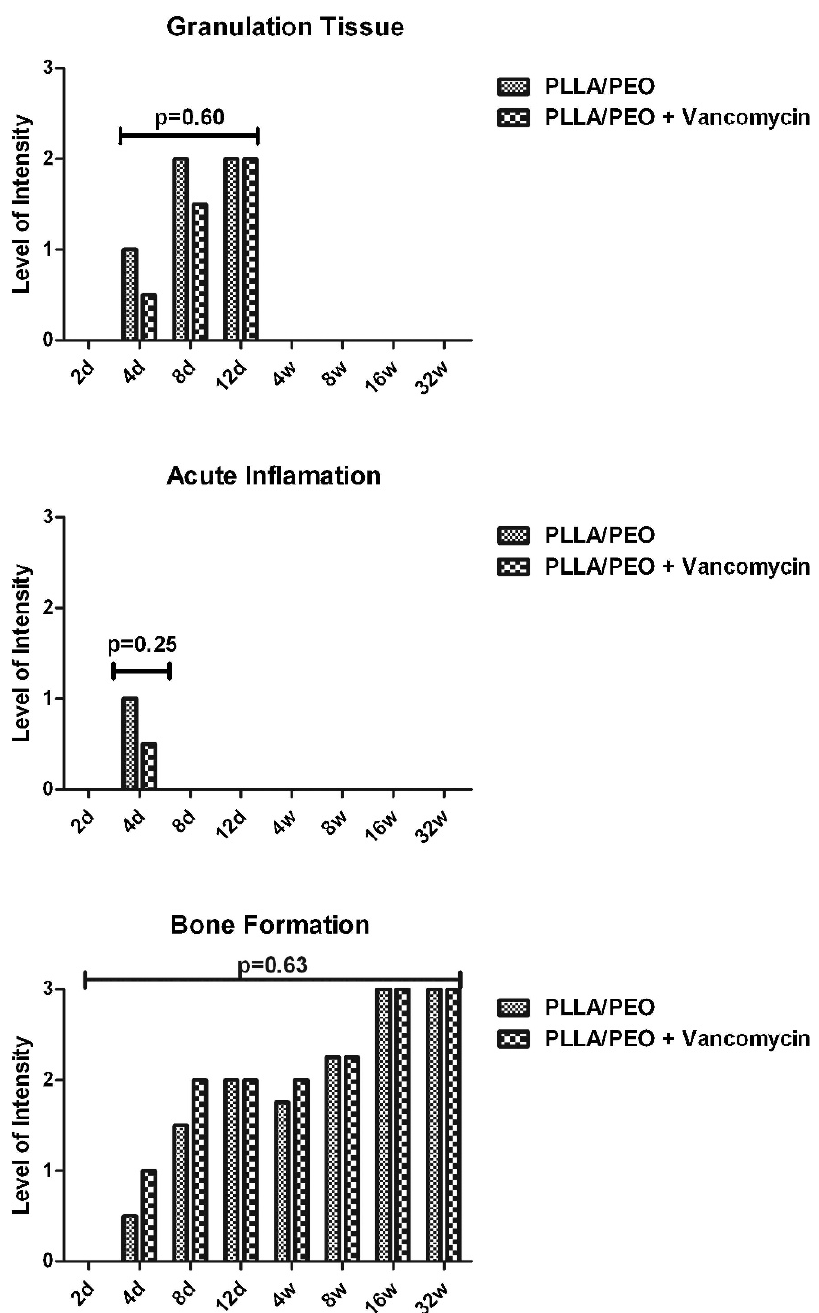
Figure 4 - Histopathological (semi-quantitative) analysis: 0=absent, 1=light, 2=moderate and 3=intense. The periods that showed no values are equivalent to